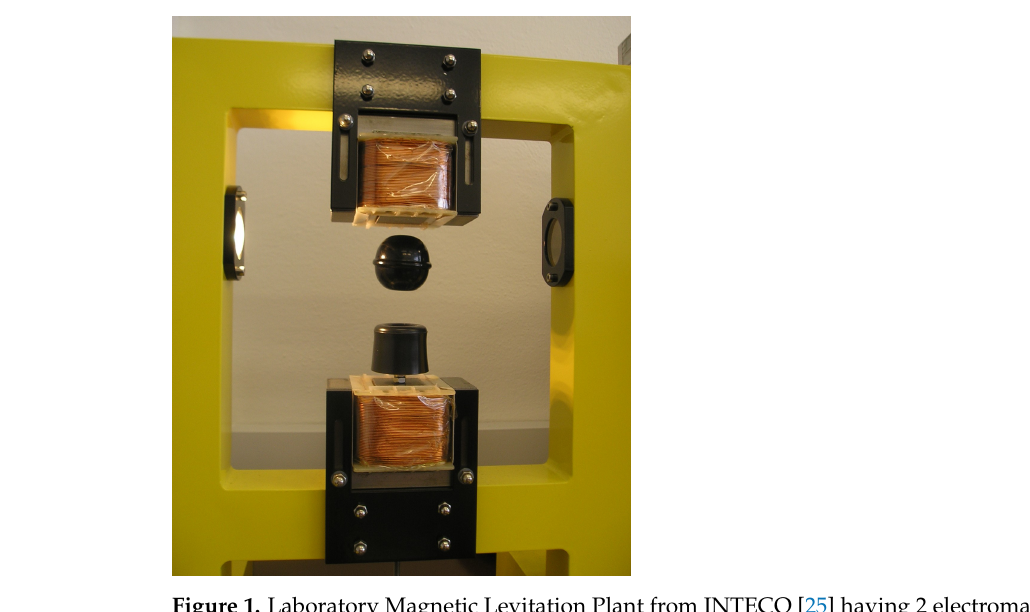
Figure 1. Laboratory Magnetic Levitation Plant from INTECO [25] having 2 electromagnets (coils). A levitating sphere ball should be positioned in the